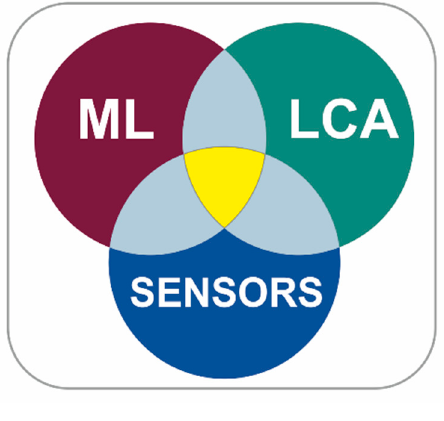
Figure 5. ML-LCA-SENSORS.